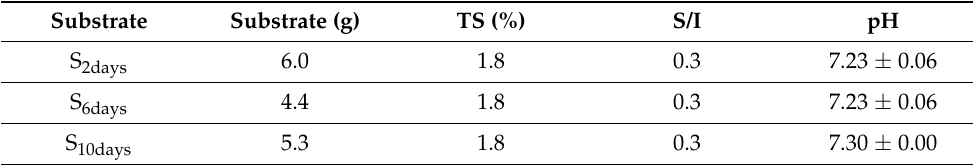
Table 2. Experimental settings of the batch reactors for the BMP tests. Substrate Substrate